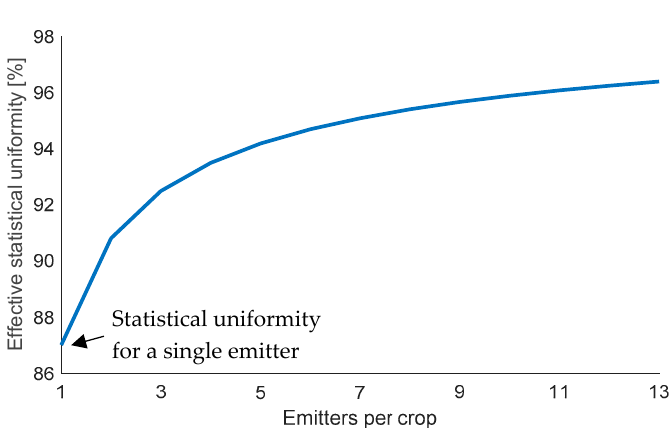
Figure A4. E ff ective statistical uniformity per crop when it is watered by multiple emitters with a certain CV m . Assuming CV m is due to random variation, positive and negative deviations from the mean flow rate of individual emitters cancel each other out, resulting in higher e ff ective uniformity. The starting point of this plot is the average measured field statistical uniformity for a single low-pressure emitter.